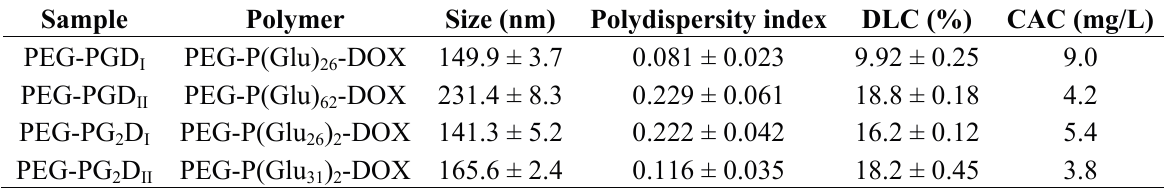
Table 2. Characteristics of different doxorubicin-conjugated micelles.